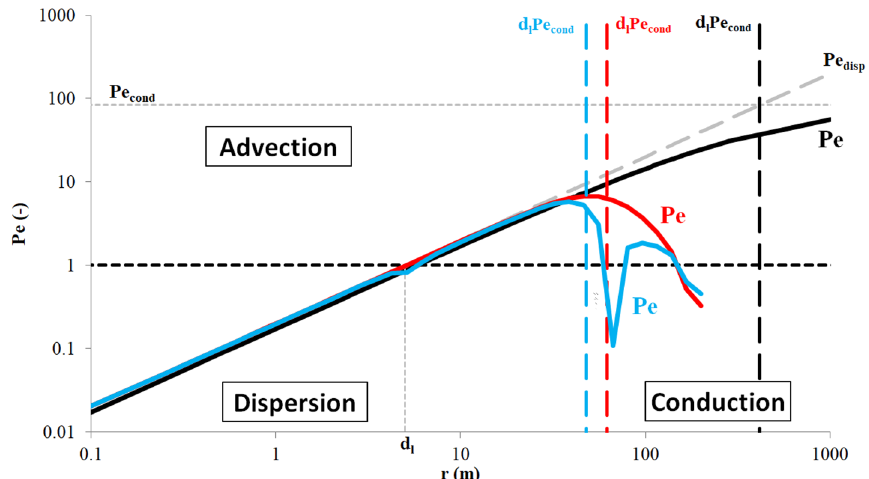
Fig. 7 Peclet number at the end of the injection (red colour) and at the end of the back injection (blue colour) in the first year of operation in the border line. Black and grey lines represent the perfectly radial Peclet. Central well is located at 0 m